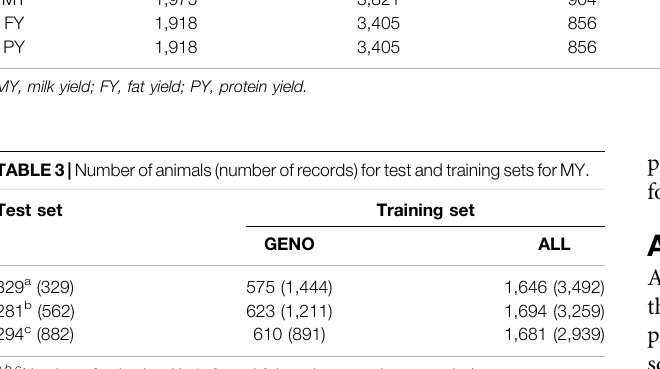
TABLE 2 | Descriptive statistics of ALL data to be used for pBLUP and ssGBLUP analyses. Trait No. of animals